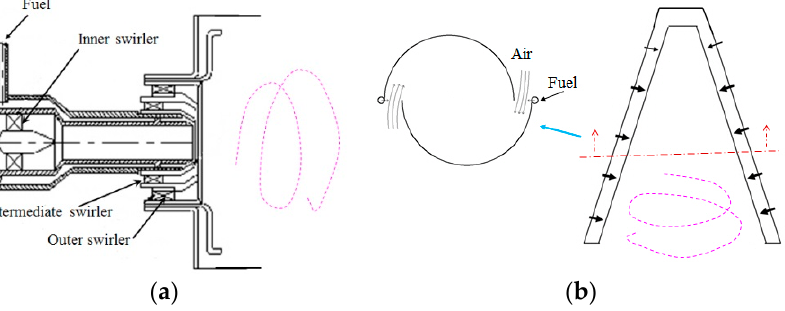
Figure 1. Different structure of combustor swirler: ( a ) multi-swirler ( b ) long conical swirler. To solve the issue of combustion instability at low operating condition, a conical swirler is introduced in this paper, as shown in Figures 2 and 3. The fuel delivery is divided into two streams at low operating conditions—Part A fuel is injected into the combustor chamber from the top of the combustor, while Part B fuel, similar to the design of A. H. Lefebvre [4], is injected at the air entrance flowing with incoming air into the cone or Part B fuel at low operating condition, the present technique using two streams of fuel combustor or